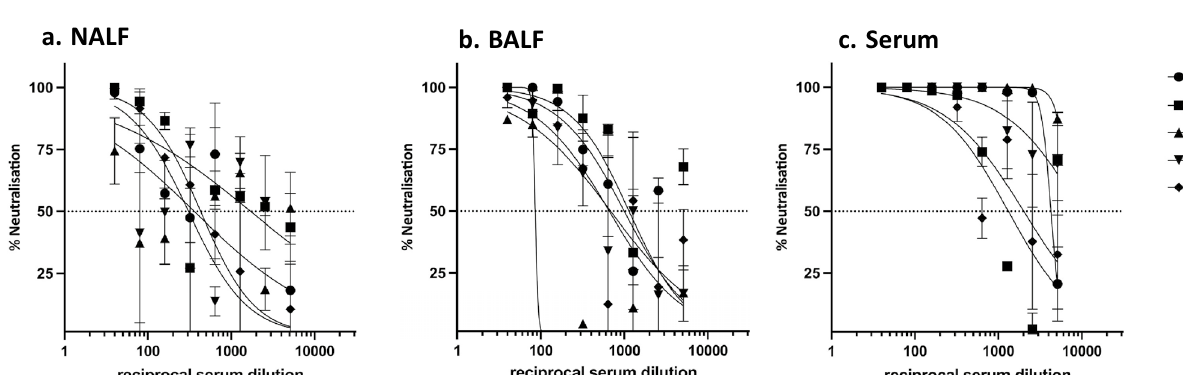
Figure 6. Monovalent influenza H1-HA 1 and bivalent SARS-CoV-2 RBD/influenza H1-HA 1 vaccines induce IgA antibody responses in NALF, BALF and serum. Mice (n = 5/group) were prime-boost immunized intranasally (days 0 and 21) with monovalent influenza H1-HA 1 -cCPE or bivalent SARS-CoV-2 RBD-cCPE/ influenza H1-HA 1 -cCPE vaccine, adjuvanted with Riboxxim. NALF, BALF and sera were obtained on day 28, 1 week after the boost, diluted in fourfold steps, and assayed for IgA antibodies by ELISA with recombinant monomeric RBD (Wuhan-Hu-1/wildtype), recombinant trimeric spike protein, or recombinant monomeric H1-HA 1 (A/swine/Guangxi/3843/2011(H1N1), respectively. Log10 of endpoint titers were plotted.